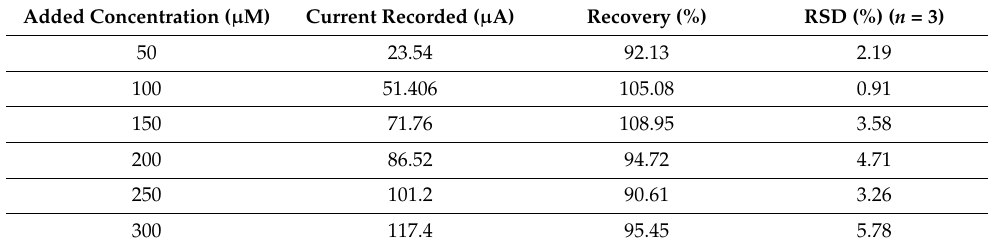
Table 3. Recovery and analysis of nitrite in groundwater by EdAu/SPCE.